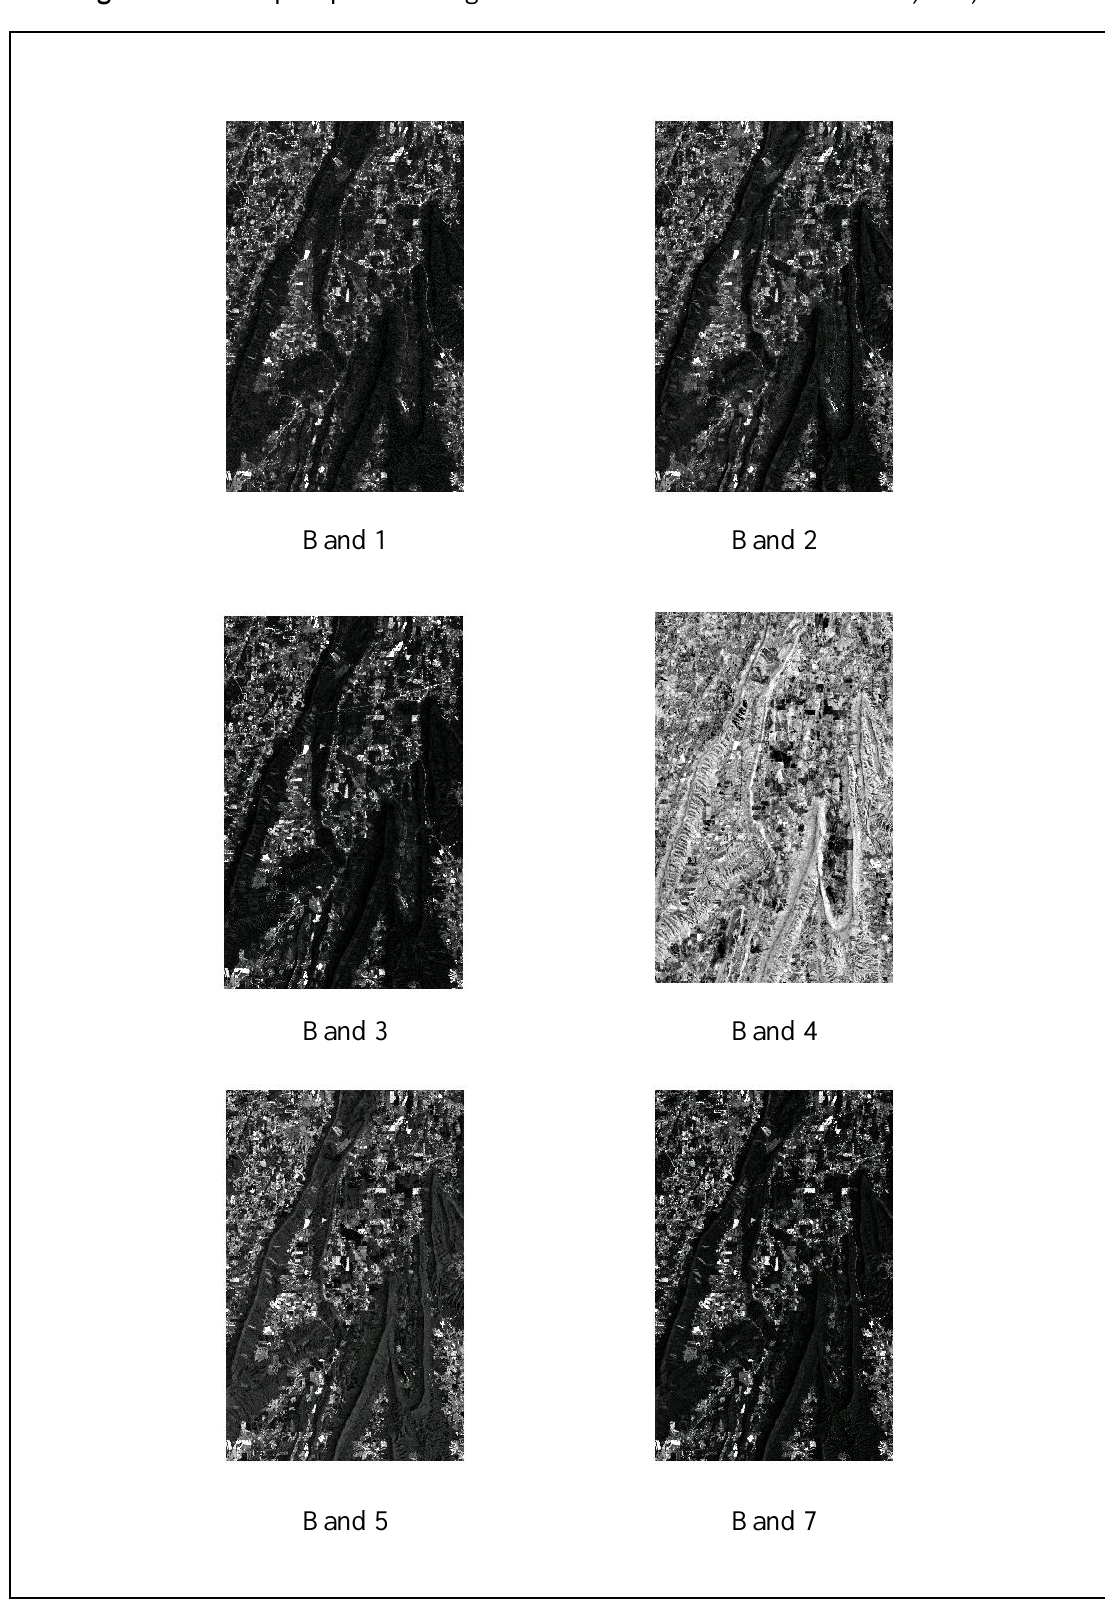
Figure 11. Multiple spectral images of Chatahoochee National Forest, GA,